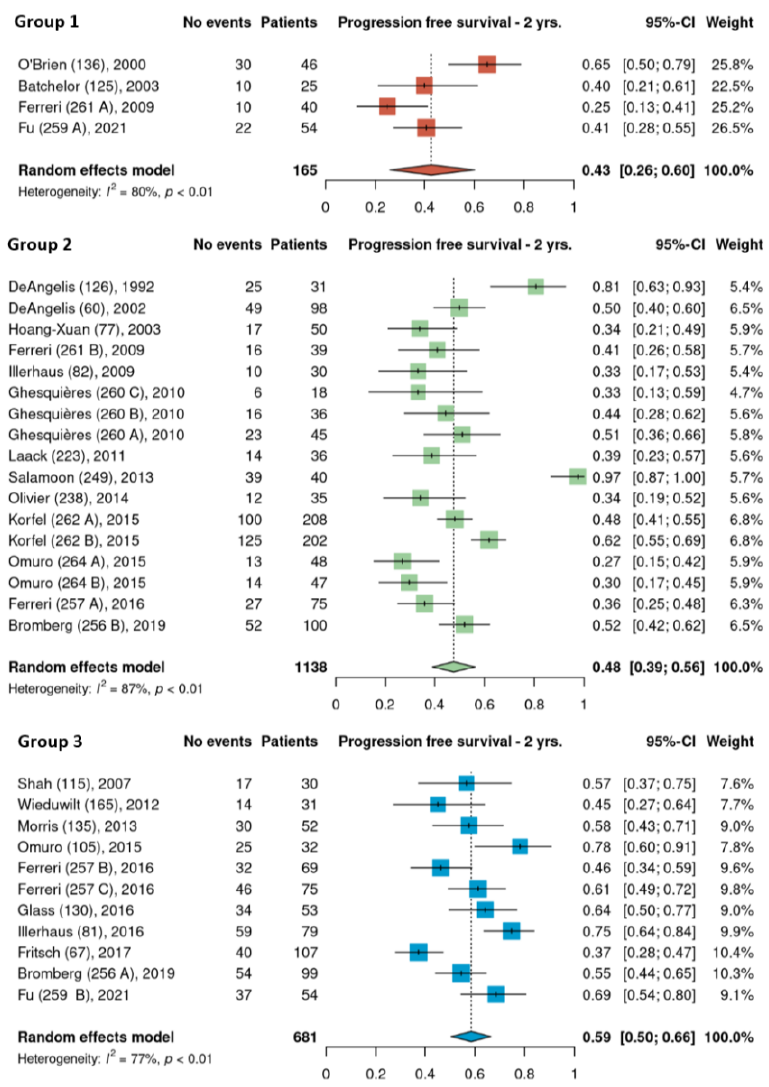
Figure 6. The 2-year progression-free survival of the different HDMTX induction regimens. Group 1, HDMTX monotherapy. Group 2, HDMTX + polychemotherapy. Group 3, HDMTX + rituximab ± polychemotherapy [12,14,15,18,21,23,24,26–39,41,42]. Pooled estimates of 2-year PFS of cohorts that received rituximab and those that did not were analyzed separately among the different HDMTX dosage categories. None of the low dose HDMTX cohorts received rituximab. For those receiving intermediate dose HDMTX (3–4.9 g/m 2 ), 2-year PFS was 58% [95% CI, 49–66%] in cohorts that received rituximab and 45% [95% CI, 35–66%] in cohorts that did not received rituximab. Among the high dose HDMTX cohorts, 2-year PFS was 61% [95% CI, 32–87%] in those that received rituximab and 40% [95% CI, 21–61%] for those that did not receive rituximab (Figure 7). Although there were four total cohorts that used high dose HDMTX, i.e., two in the rituximab (+) group and two in the rituximab ( − ) groups, 2-year PFS data was missing from one cohort from the rituximab ( − ) group.